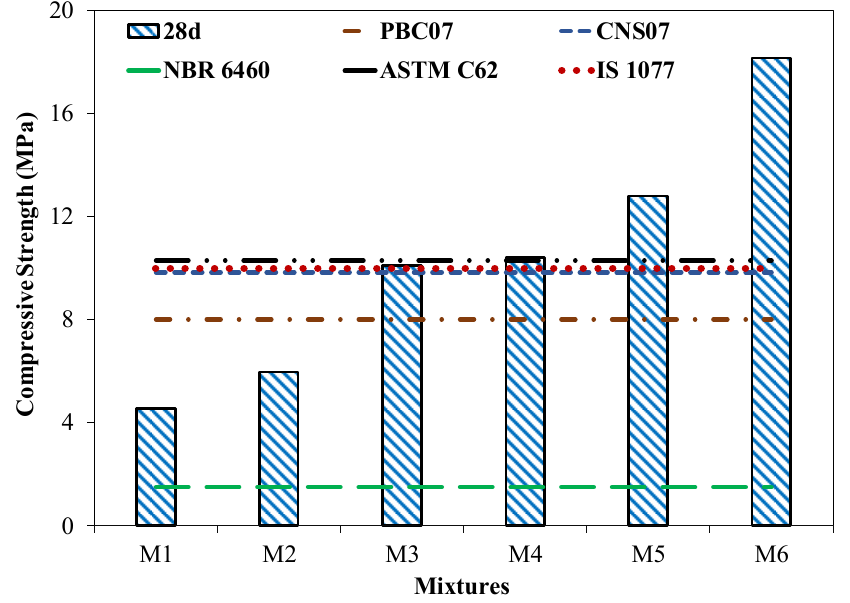
Figure 9. Compressive strength of the brick specimen with different CA contents. Table 3. Test results and coefficient of variation (COV) for different mixtures.